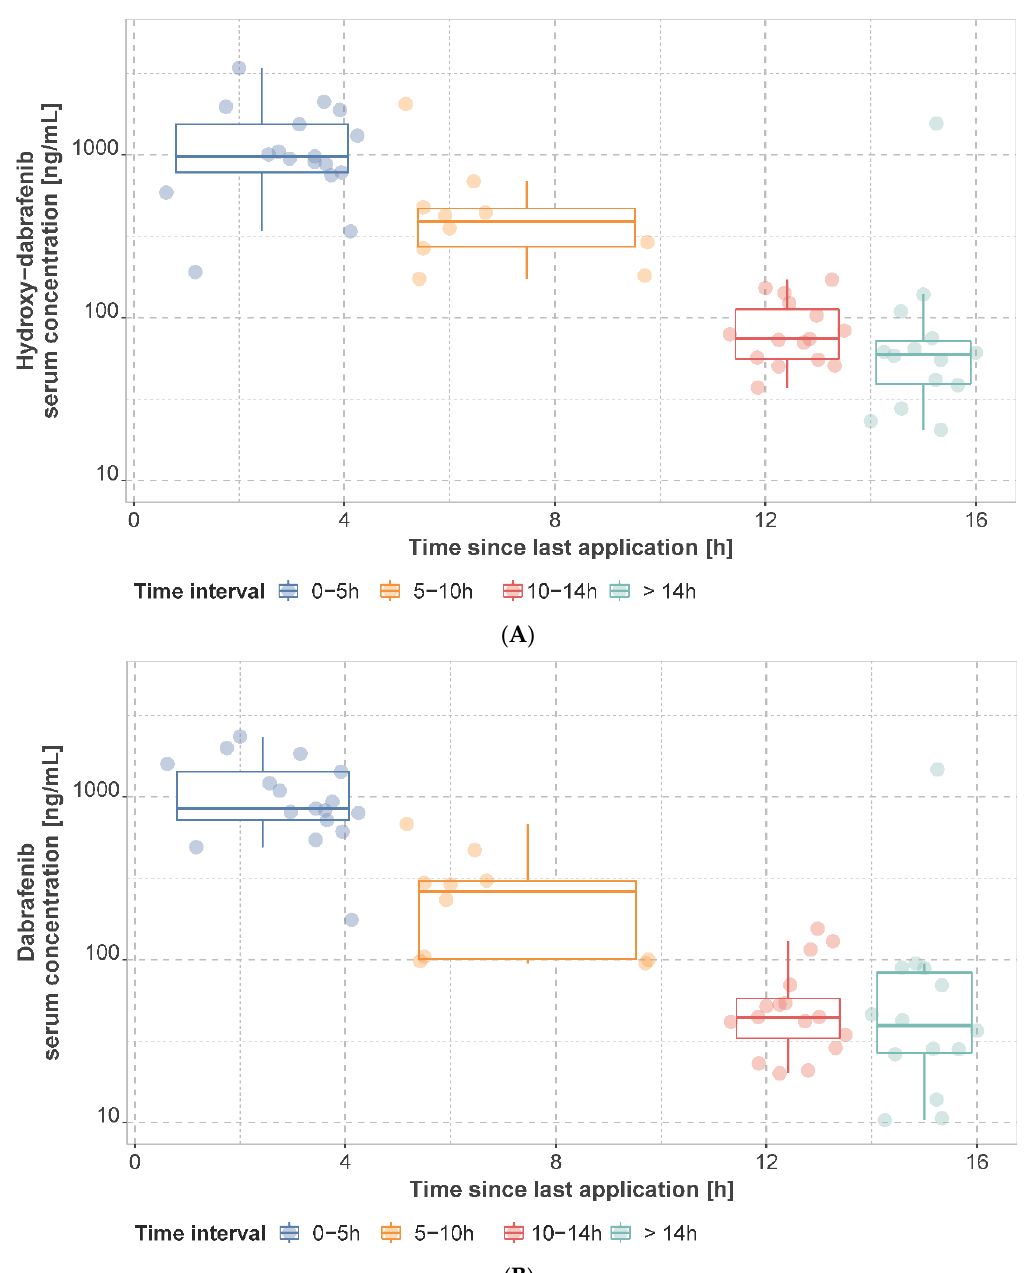
Figure 2. Observed hydroxy − dabrafenib ( A ) and dabrafenib ( B ) serum concentrations. Concentra- tions are presented as mean concentration per patient at steady state stratified by sampling time interval. Patients may have contributed samples at multiple time intervals. Figure 3. Observed trametinib serum concentrations. Concentrations are presented as mean concen- tration per patient in steady state stratified by sampling time interval. Patients may have contributed samples at multiple time intervals.